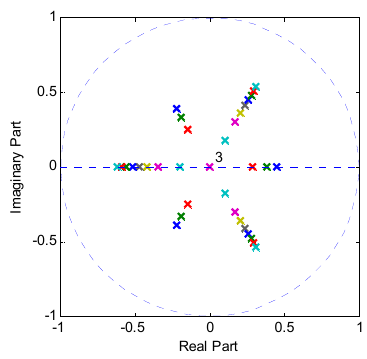
Figure 6. Pole distribution of the current loop.